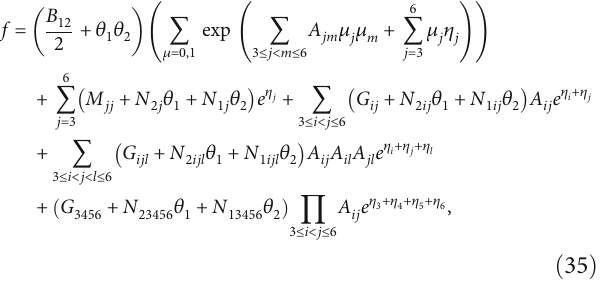
gate along the negative direction of the x -coordinate. They